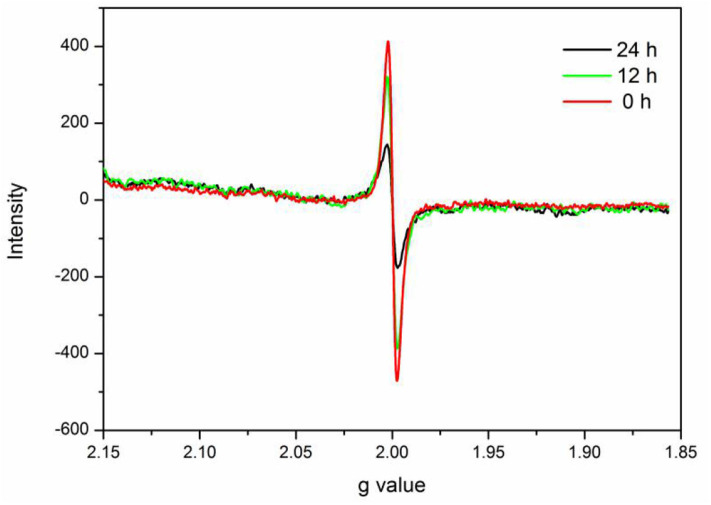
ESR spectra of m-BiVO4-Ovac, BiVO4-Ovac-12h, and BiVO4-Ovac-24h.